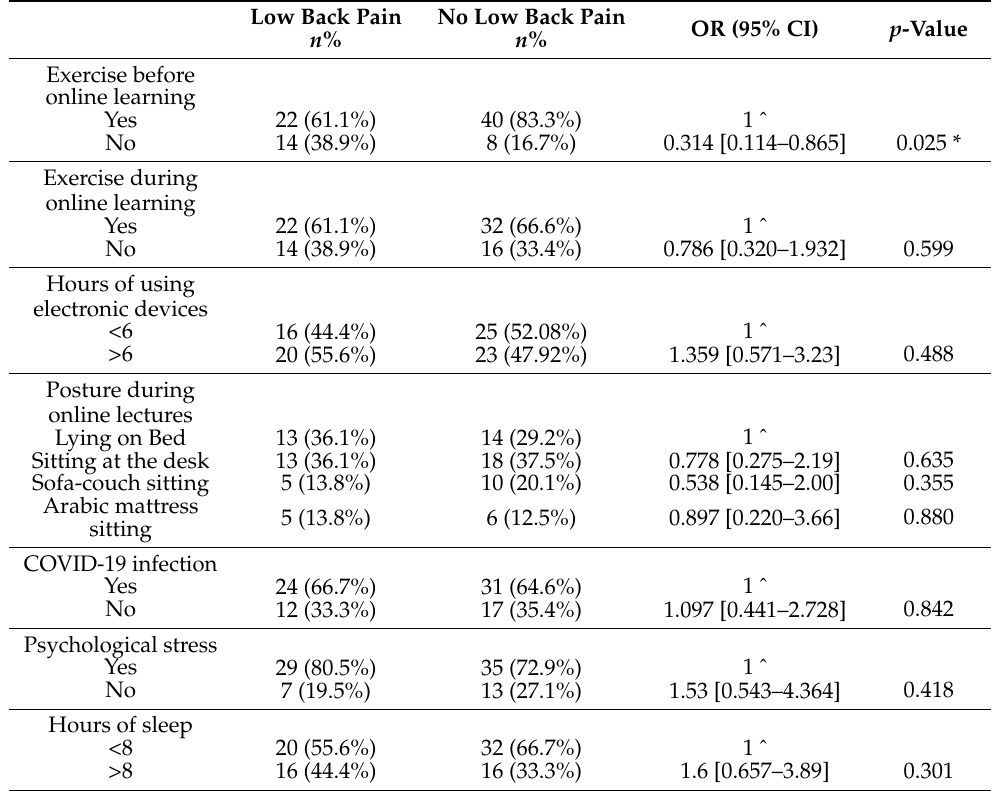
Table 7. Association between low back pain and physical